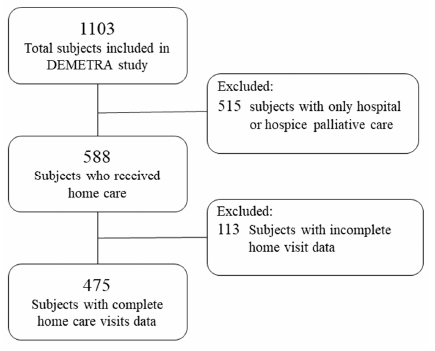
Figure 1. Flowchart of selection of the cohort.